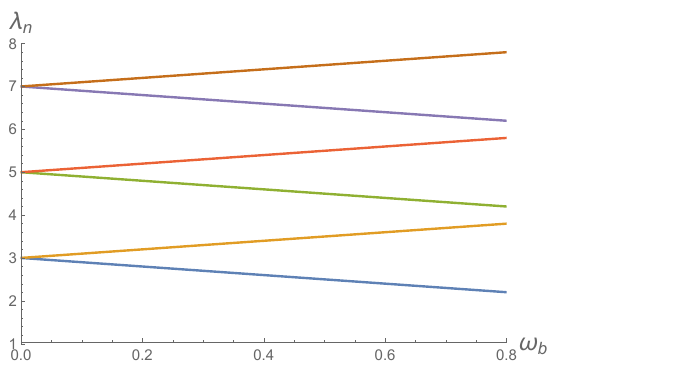
Figure 42 . Second and third modes repelling at (cid:30) b = : 2 (left) and (cid:30) b = : 1 (right).